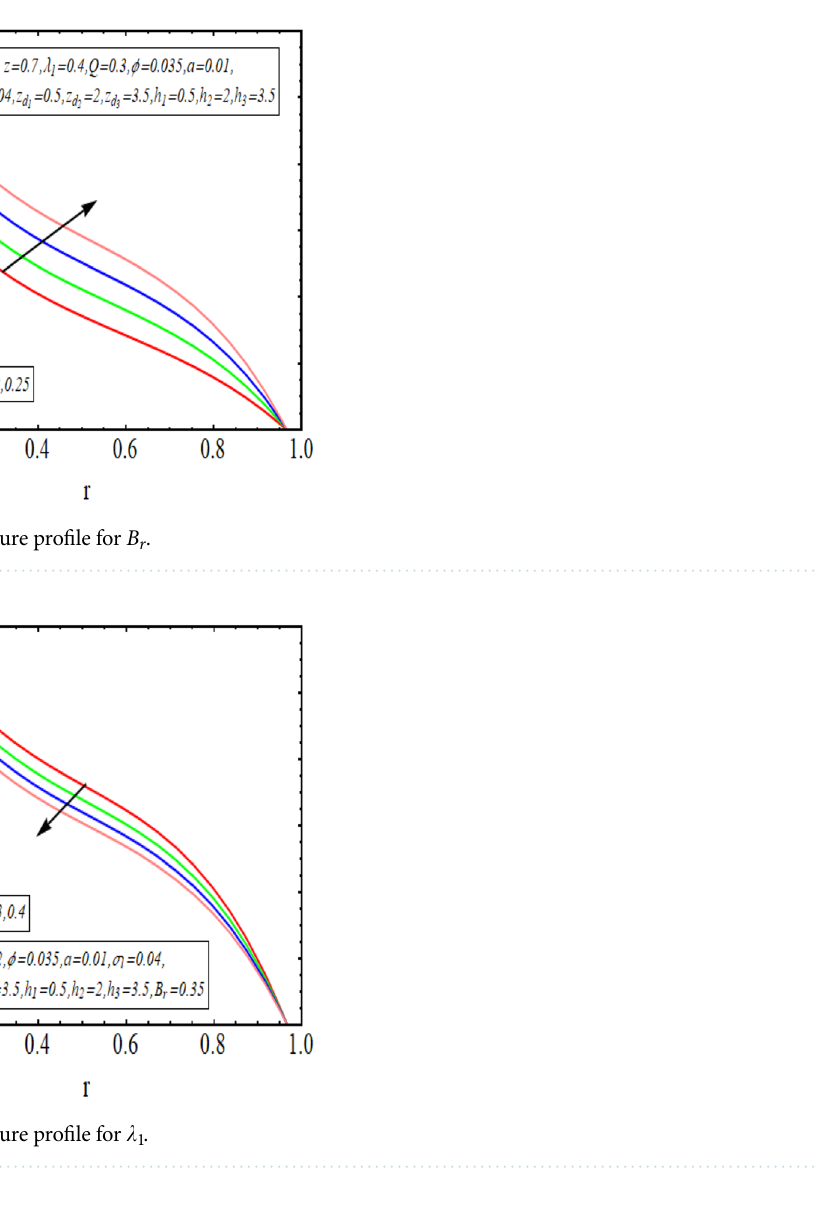
results (Figs. 16, 17, 18 and 19) are plotted for varying heights of multiple thrombosis and the variation in the height of these multiple thrombosis is noted in these graphs. In this way, we have also covered the present topic for different heights of multiple thrombosis. Figures 16, 17, 18 and 19 displays a streamlined graph for increas- ing values of σ l . It is interesting to note the increase in height of multi-thrombosis in these streamlines graphs.